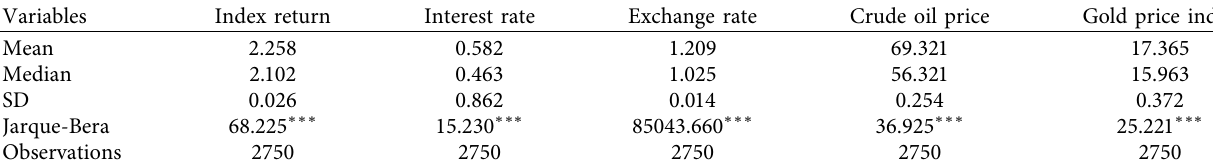
Figure 2: Computation of coefficients for macroeconomic Table 2: Descriptive statistics for the United States.